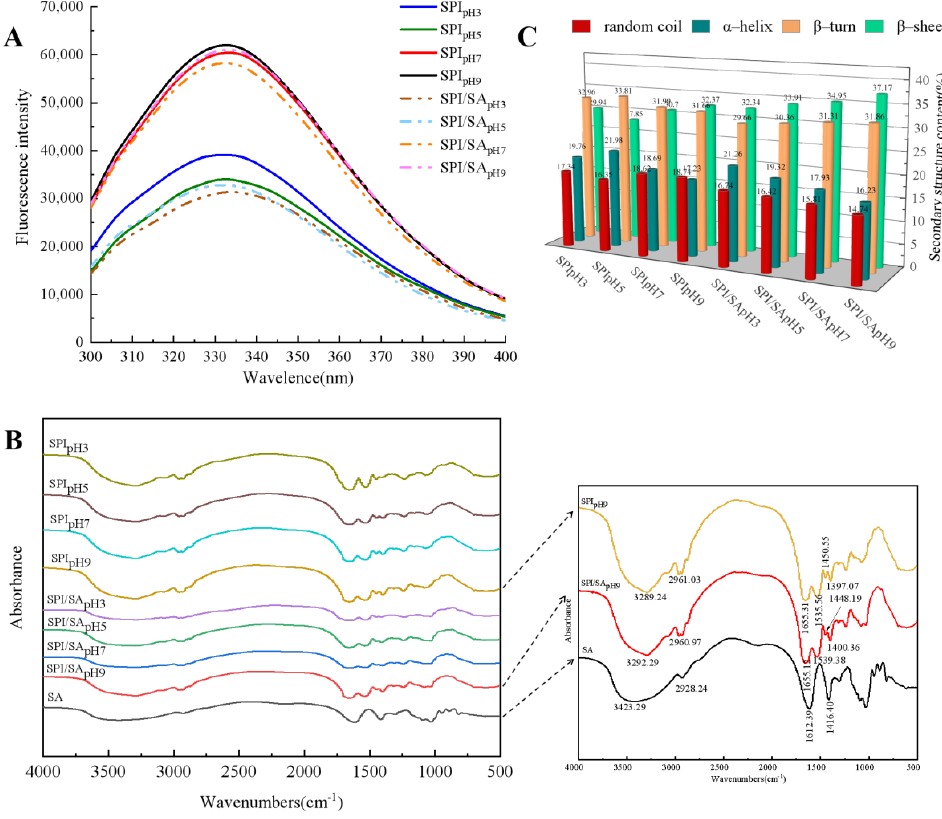
Figure 2. Fluorescence spectra ( A ), FTIR spectra ( B ), and secondary structure content ( C ) of SPI and SPI/SA microparticles at different pH values.